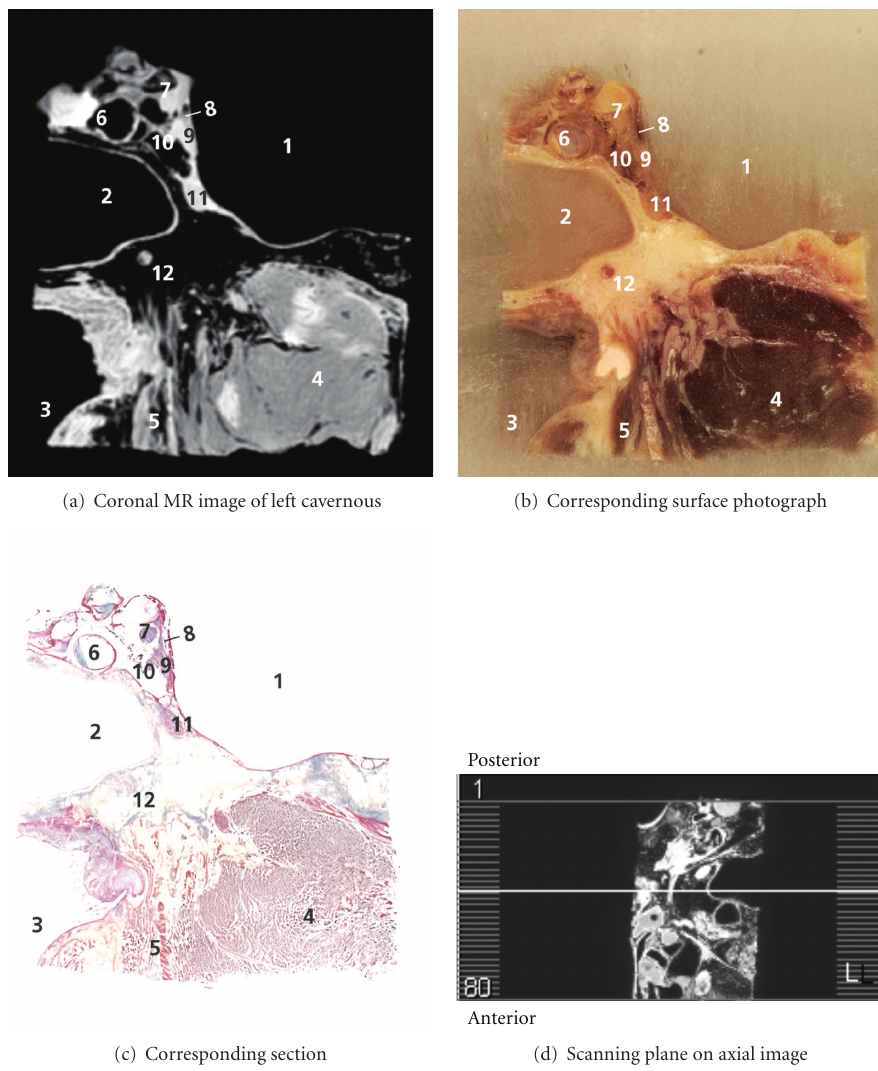
Figure 5: 1–3: see Figure 4. 4: lateral pterygoid muscle, 5: tensor veli palatini muscle, 6: internal carotid artery, 7: oculomotor nerve, 8: trochlear nerve, 9: ophthalmic nerve, 10: abducens nerve, 11: maxillary nerve, and 12: nerve of the pterygoid canal or Vidian